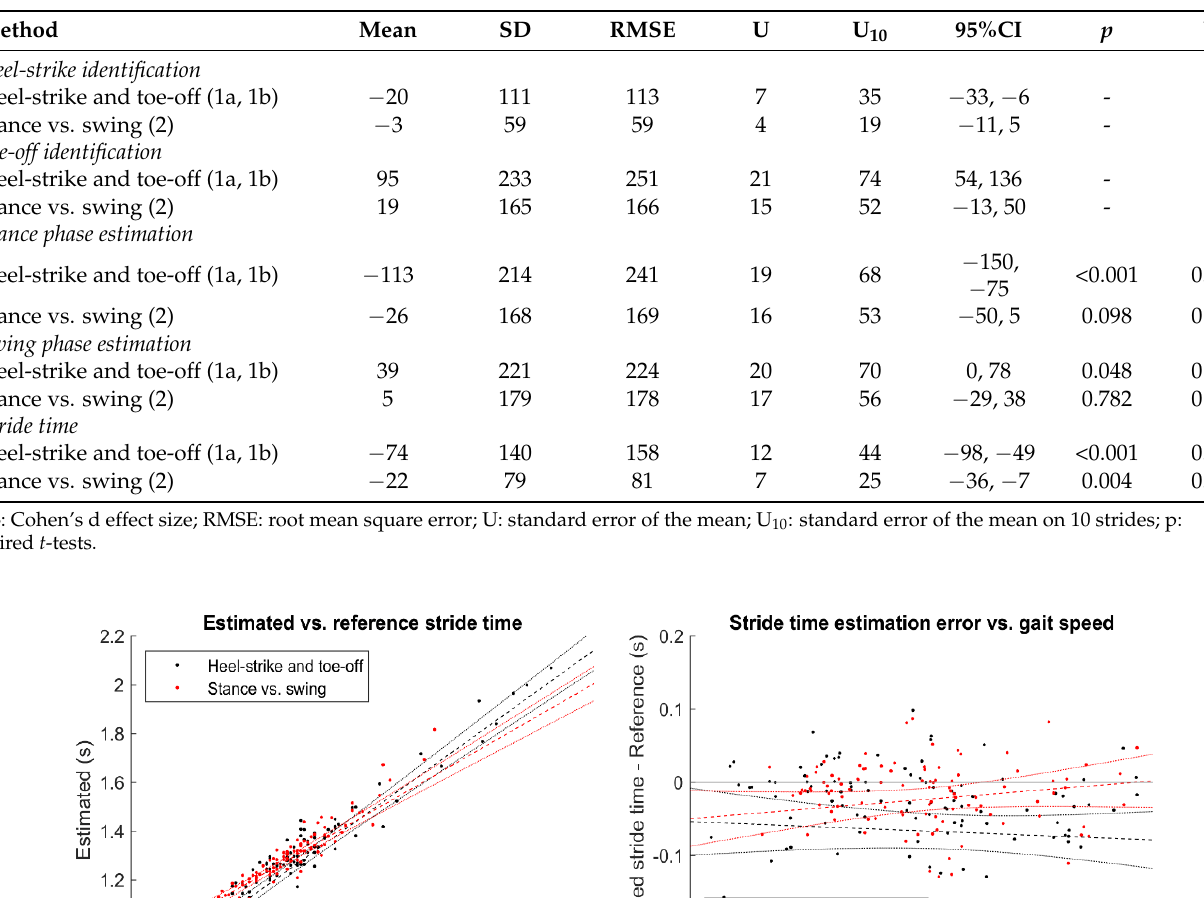
equal to 0.004 ( p = 0.482, approach 1a and 1b) and 0.021 ( p = 0.135, approach 2). Table 3. Descriptive statistics (in ms) of the heel-strike and toe-off identification, as well as swing/stance/stride time esti- mation, with respect to the reference system (force platform).